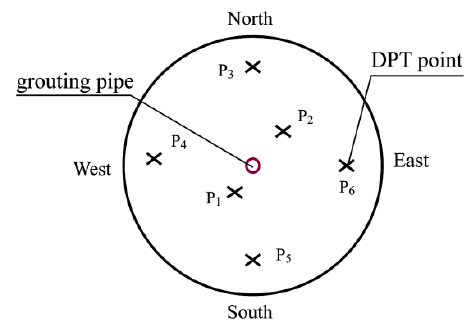
Figure 14. Arrangement of light dynamic penetration points.